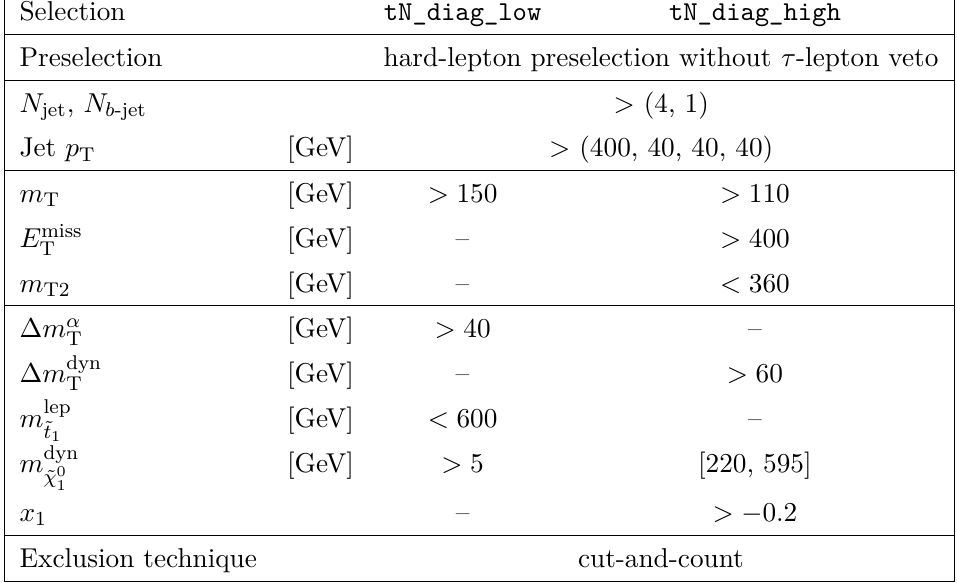
Table 5. Event selections defining the signal regions tN_diag_low and tN_diag_high .